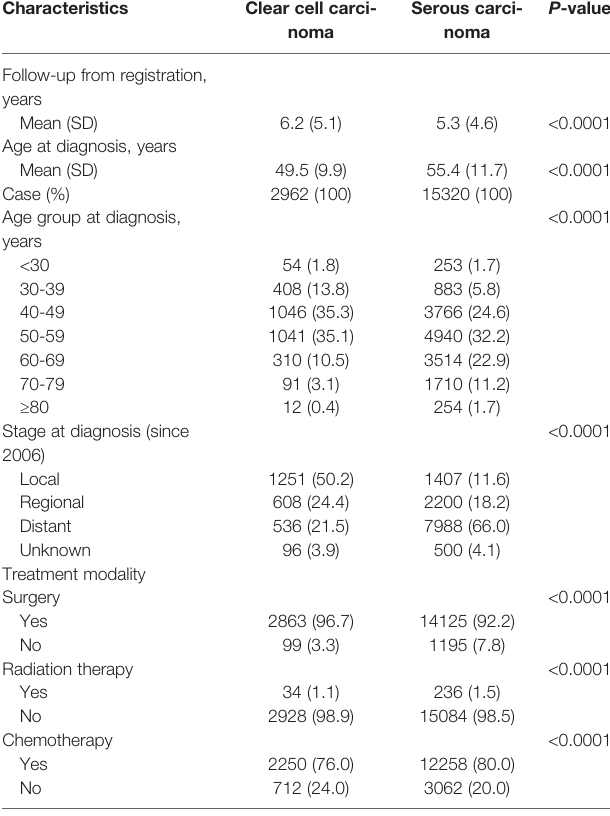
TABLE 3 | Characteristics of patients with primary ovarian clear cell carcinoma and serous carcinoma in Korea. Characteristics Clear cell carci-